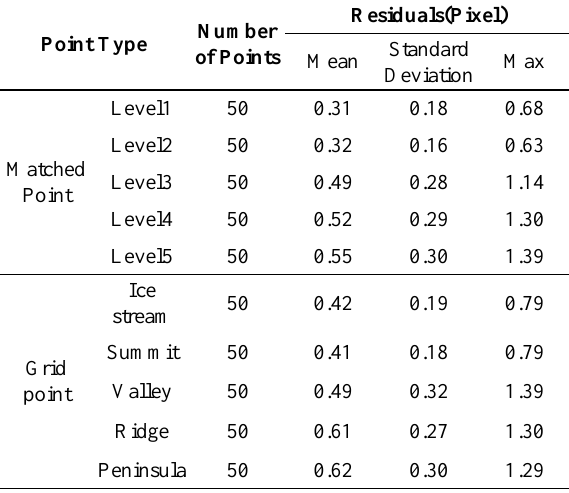
Table 3. Matching Residuals at 6